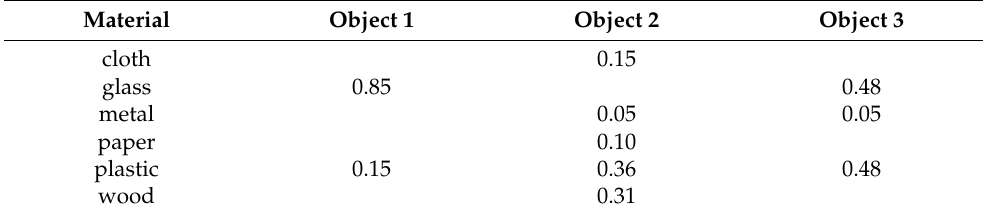
Figure 6. Examples of images acquired by object recognition in the usage environment. Table 2. Ratio classified into each material label. Table 2. Ratio classified into each material